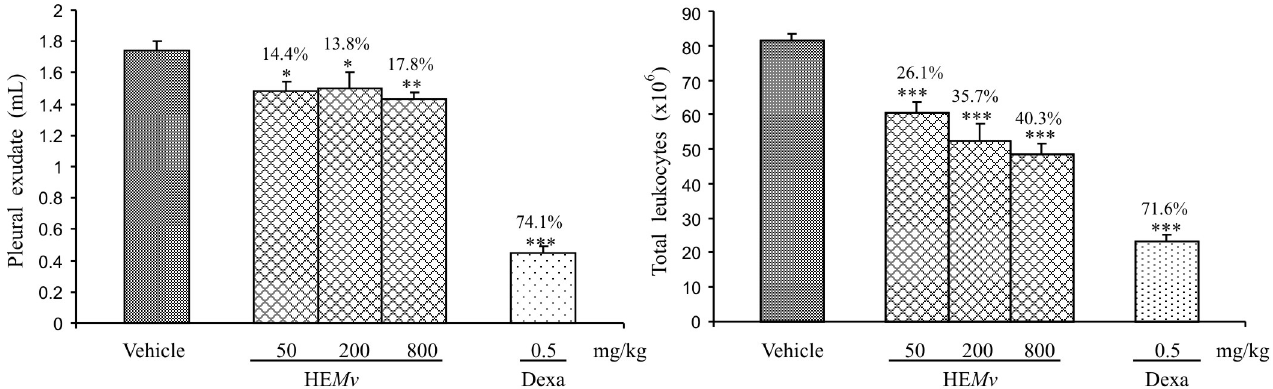
FIGURE 3 - Effect of hydroethanolic extract of M. velame on exudate and cell migration carrageenan-induced in rats. Each value is the mean ± S.E.M. of 7-8 rats. *p<0.05, **p<0.01, ***p<0.001 compared with control. One-way ANOVA followed by Student- Newman–Keuls.